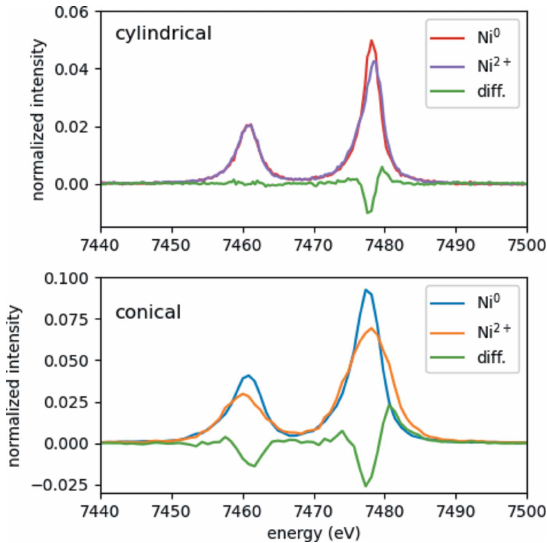
Figure 11 Ni K (cid:2) spectra of metallic Ni and ionic Ni 2+ (in the form of NiSO 4 powder) recorded by von Ha´mos spectrometers with cylindrical (top panel) and conical (bottom panel) analyzer